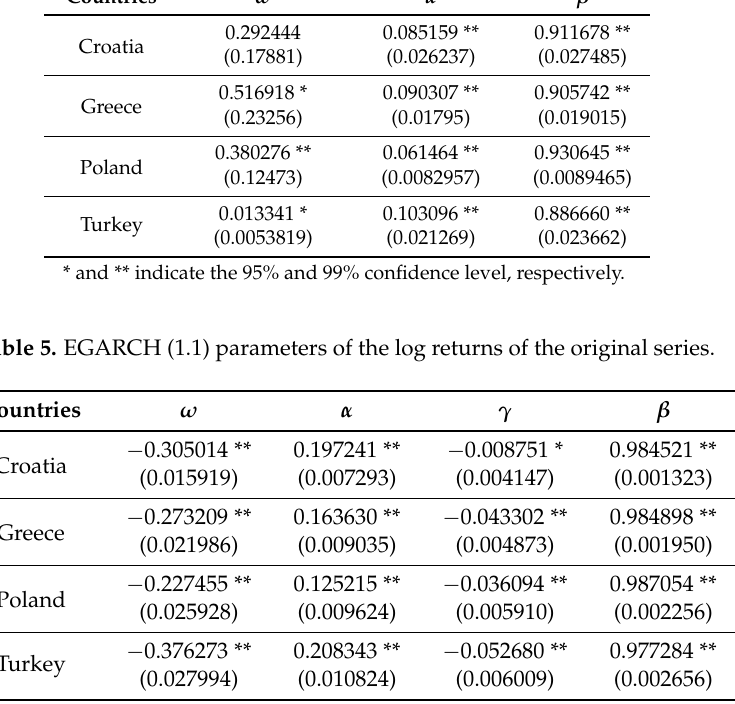
Table 4. GARCH (1.1) parameters of the log returns of the original series. Countries